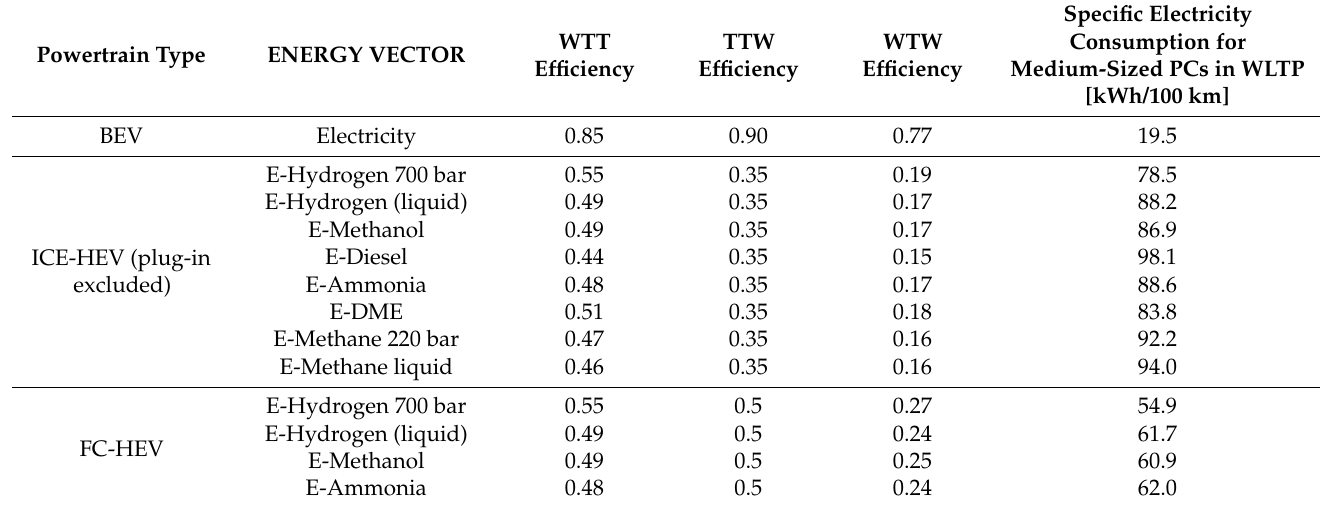
Table 10. Energetic comparison of e-fuels and batteries in medium-sized